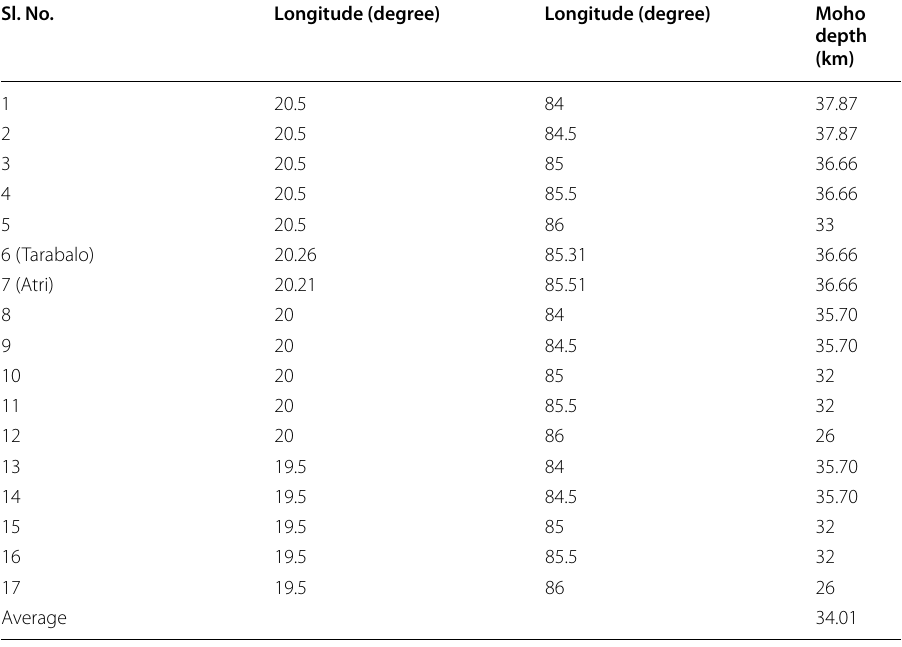
Table 1 Moho depth variation over the study area as calculated by CRUST1.0 model (Laske et al. 2012) Sl.